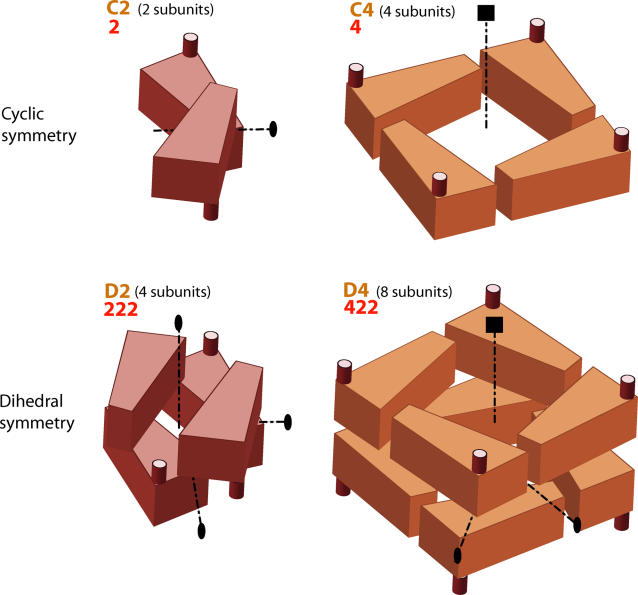
Cyclic and Dihedral Symmetries(C2) Cyclic symmetry: two subunits are related by a single 2-fold axis, shown by a dashed line. An ellipse at the end of the symmetry axis marks a 2-fold axis. Nearly all homodimers have C2 symmetry. C2 symmetry is termed “2” in the crystallographic Hermann-Mauguin nomenclature, shown in red beneath C2.(C4) Cyclic symmetry: four subunits are related by one 4-fold axis. A square at the end of the symmetry axis marks a 4-fold axis.(D2) Dihedral symmetry: four subunits are related by three 2-fold axes. D2 symmetry can be constructed from two C2 dimers. Note the difference between the D2 and C4 symmetries: two symmetry types that both have four subunits.(D4) Dihedral symmetry: eight subunits are related to each other by one 4-fold axis and two 2-fold axes. Note that D4 symmetry can be constructed by stacking two C4 tetramers as shown, or four C2 dimers (not shown).